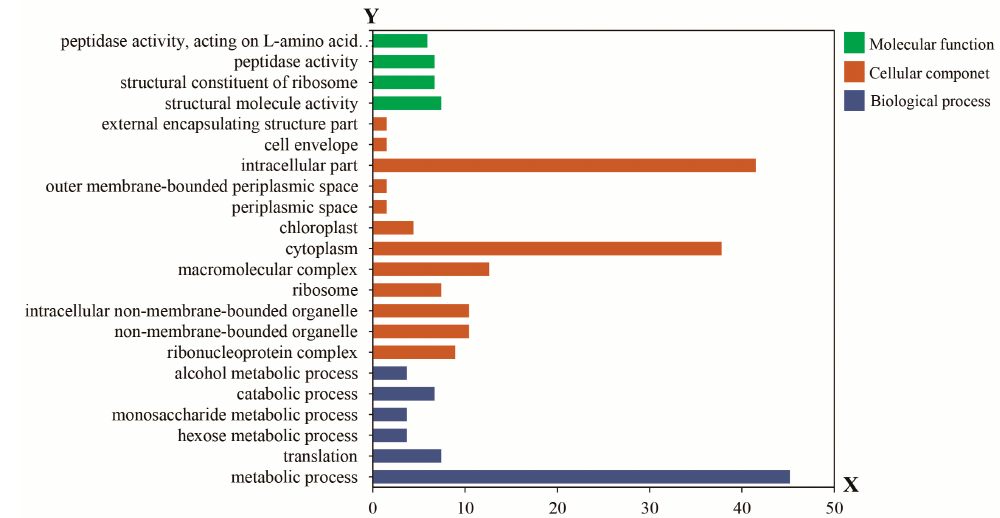
Figure 2. Gene Ontology enrichment analysis results for differentially expressed proteins. The X axis represents the number of differentially expressed proteins; the Y axis represents the Gene Ontology functional classification.